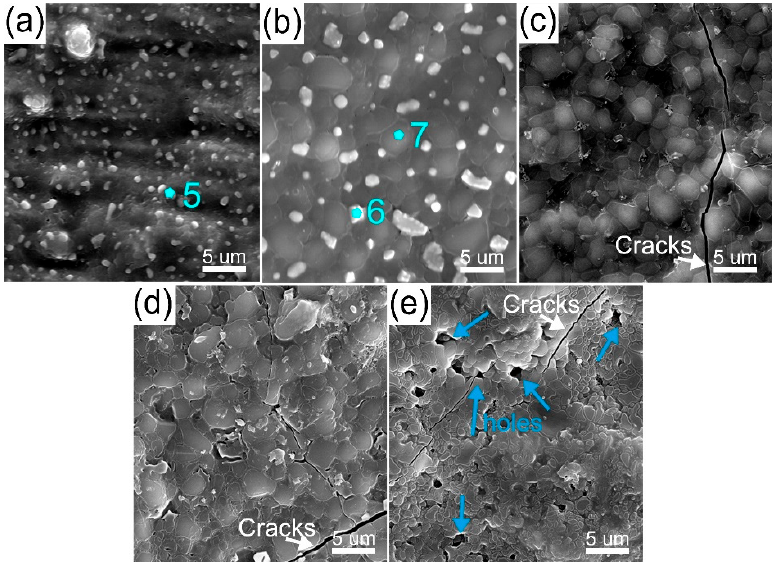
Figure 3. The surface SEM image of as-oxidized specimens: ( a ) 1100 ℃ ,2 h; ( b ) 1200 ℃ ,2 h; ( c ) 1300 ℃ ,2 h; ( d ) 1300 ℃ ,10 h; ( e ) 1300 ℃ ,15 h.